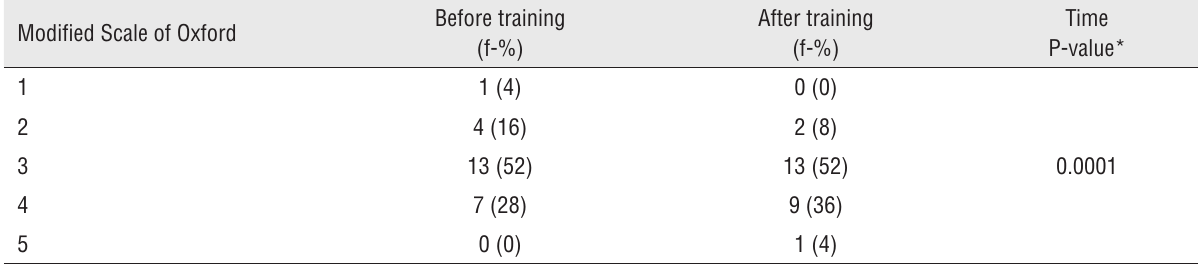
Before training